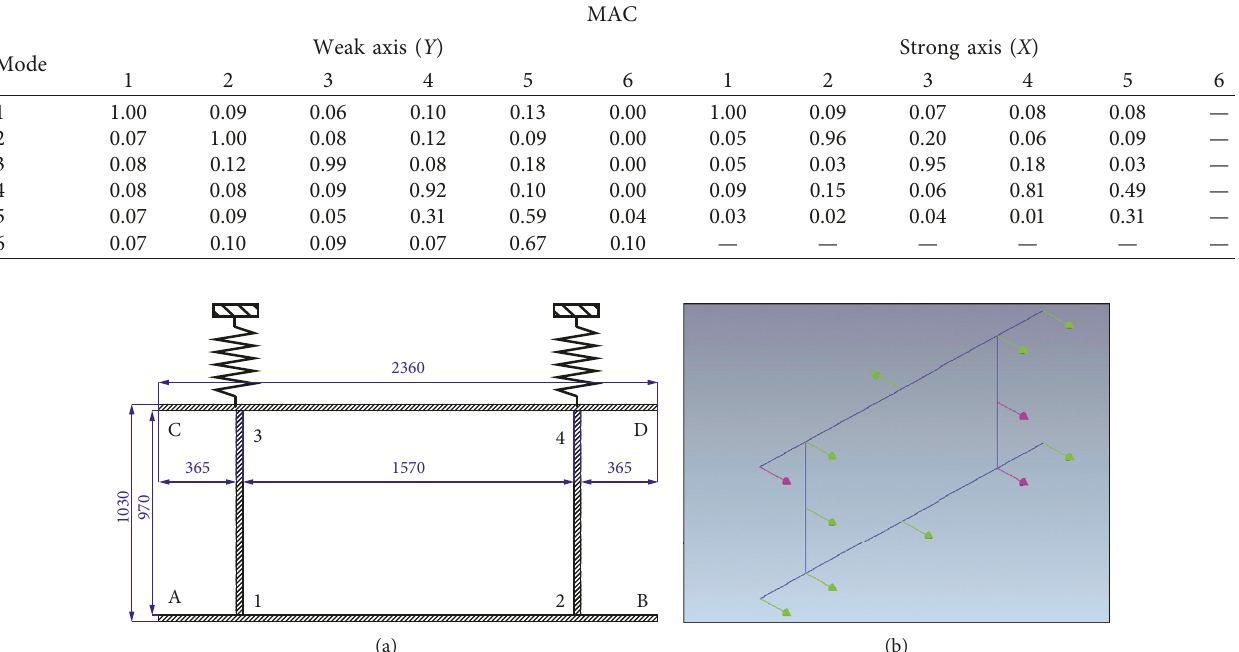
Figure 13: Geometry of the structure (a) and the setup for the free-free configuration (b).